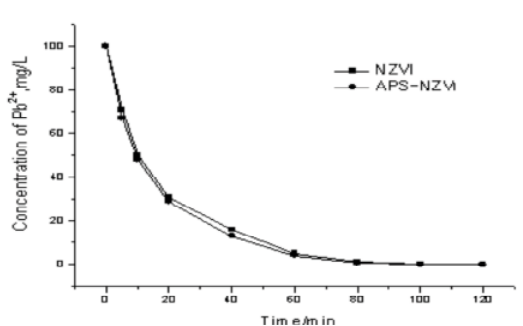
Figure 6. Effect of the mass of adsorbent on lead removal